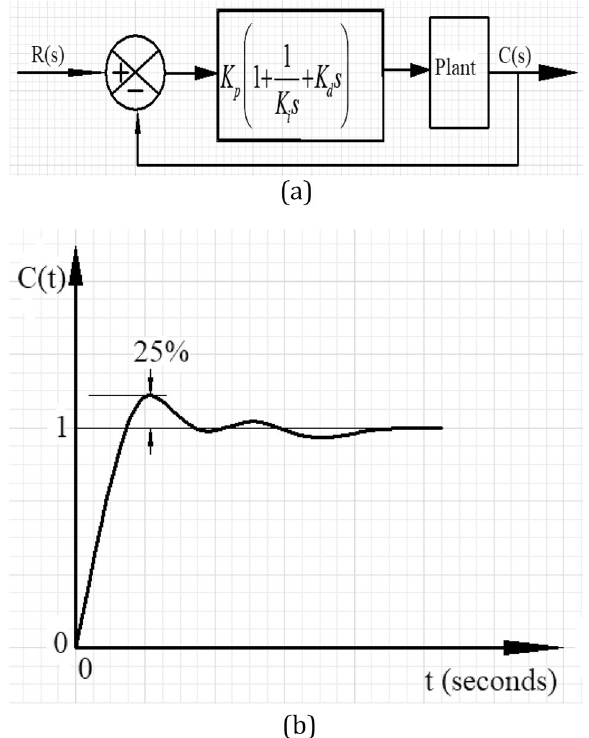
Fig. 3 PID control of a plant ( a ), Unit-step response curve showing 25% maximum overshoot ( b )